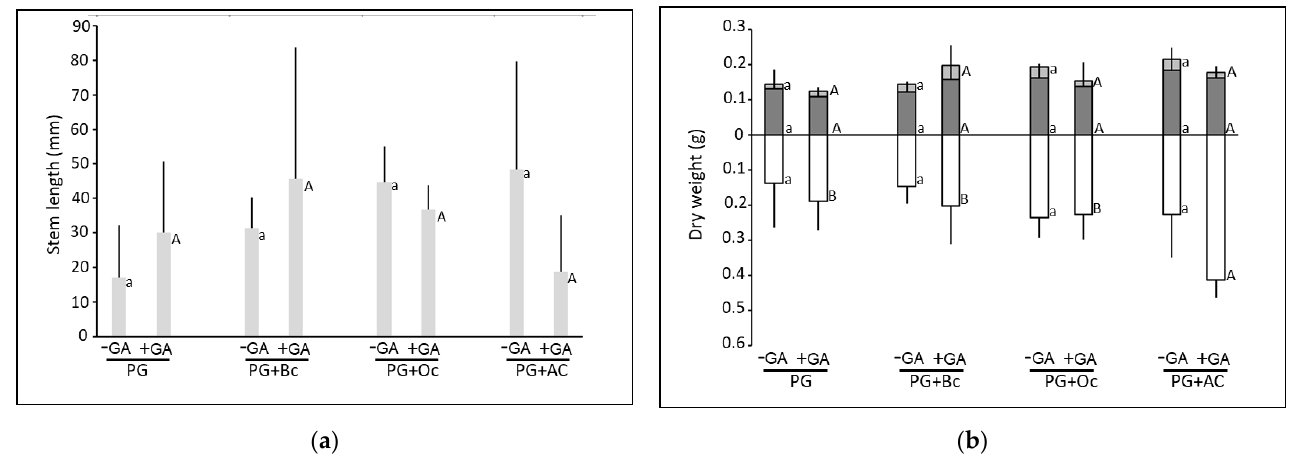
Figure 2. Stem length (mm) ( a ) and leaf (light grey), stem (dark grey) and root (white) dry weight (g), ( b ) of Populus ×. canescens after 45 days of growth on Pontgibaud technosol alone (PG) or amended with biochar (PG+Bc), ochre (PG+Oc) and activated carbon (PG+AC), associated or not with green amendment (+/ − GA). Small letters indicate a significant difference between the treatments without green amendment while capital letters indicate a significant difference between the conditions with the green amendment (p < 0.05) (n = 5 ± SE).